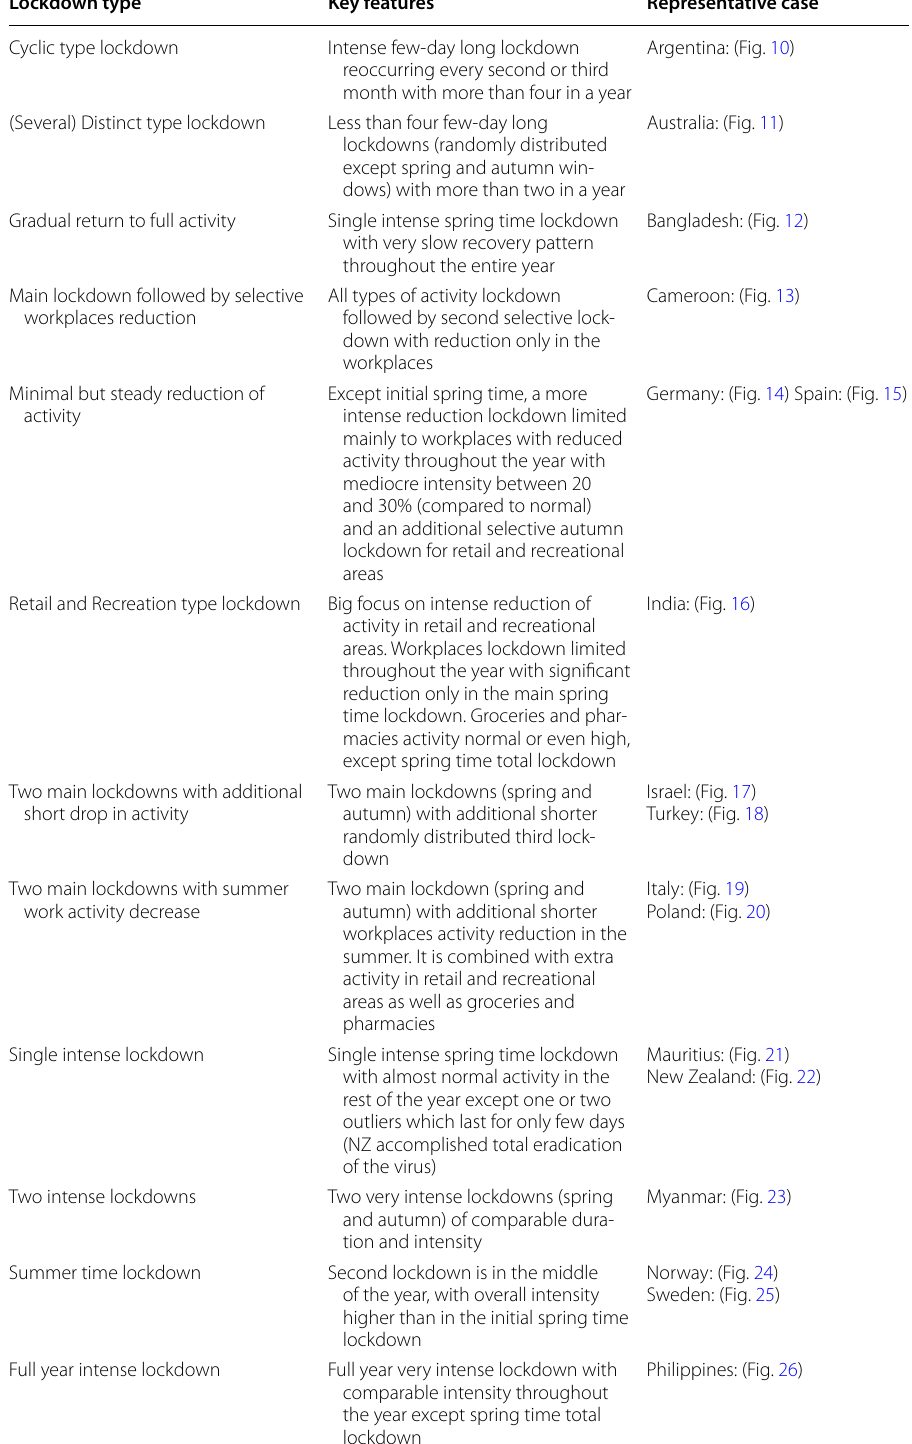
Table 6 Covid-19 Lockdown’s Taxonomy based on three economy-related types of activities in 2020 (1. groceries & pharmacies 2. retail & recreation areas 3.